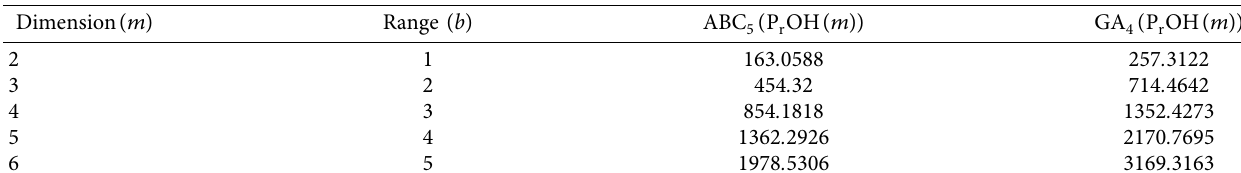
and ABC for prism octahedron network. 4 5